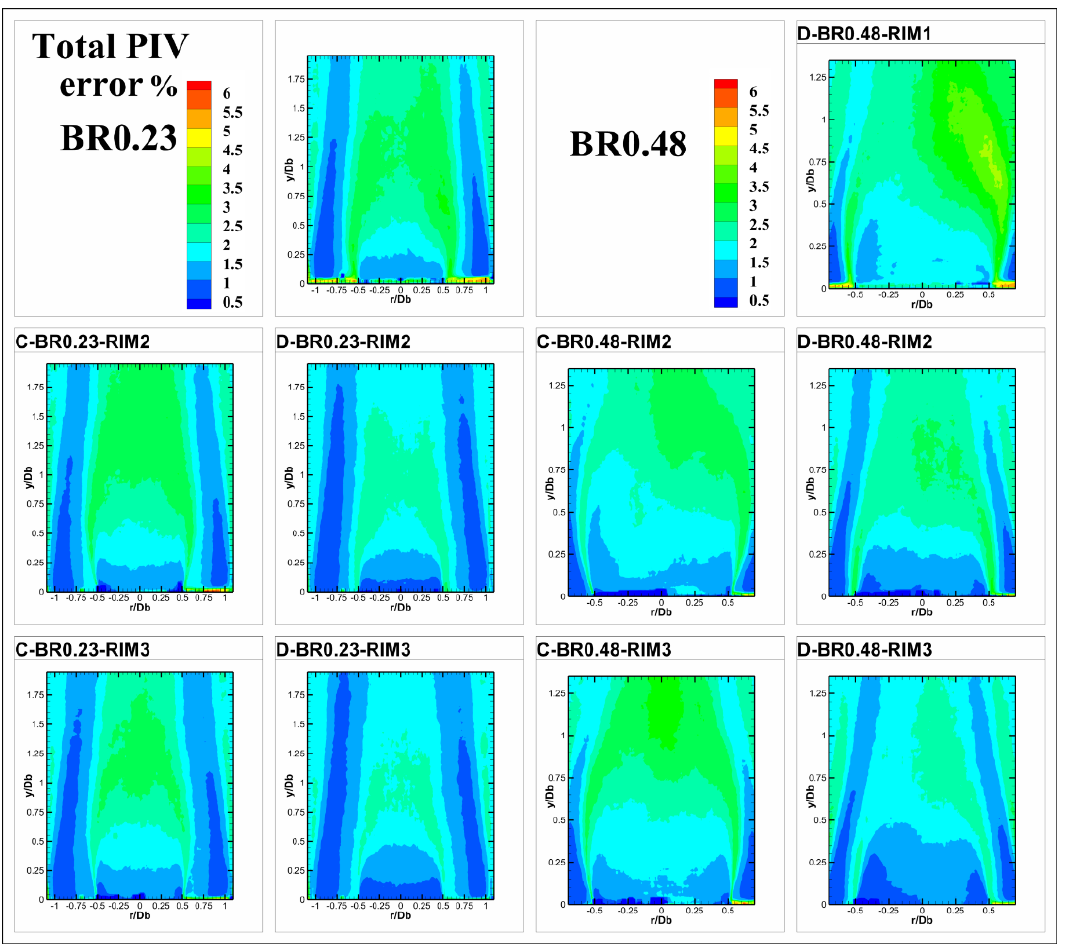
Figure A1. Contours of the total uncertainty in the estimation of velocity due to equipment, particle dynamics and sampling, for all the studied